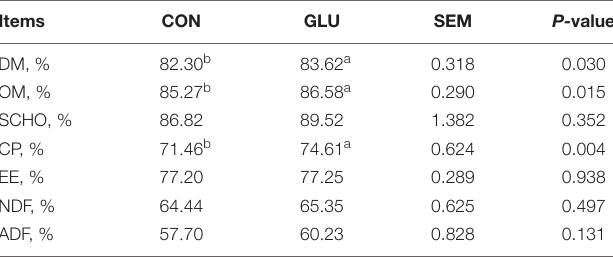
1 CON, basal diet group; GLU, basal diet + 3 g/head/day glutamate group; M, dry matter; OM, organic matter; CP, crude protein; EE, ether extract; NDF, neutral detergent fiber; ADF, acid detergent fiber; SCHO, soluble carbohydrates. a , b Different superscripts indicate significant differences within a row (P < 0.05).